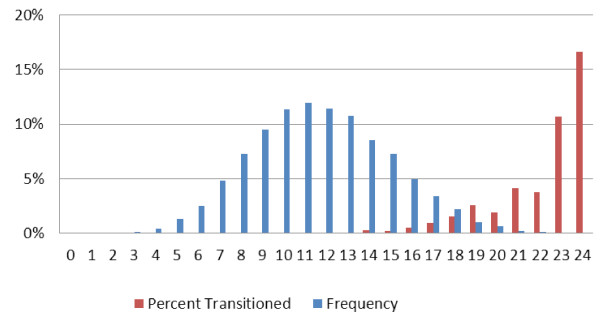
ROC Curve for Q+ Index Thresholds (Three State Data, N= 17,476, including 327 NFT).